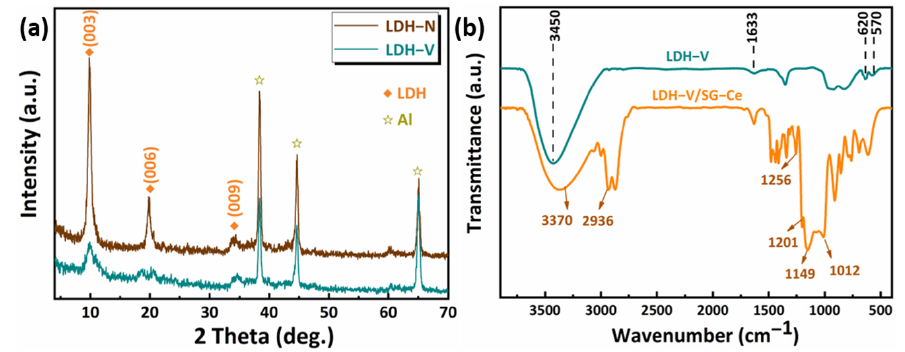
Figure 2. ( a ) XRD patterns of LDH ‐ N and LDH ‐ V films; ( b ) FTIR spectra of LDH ‐ V and LDH ‐ V/SG ‐ Ce films.